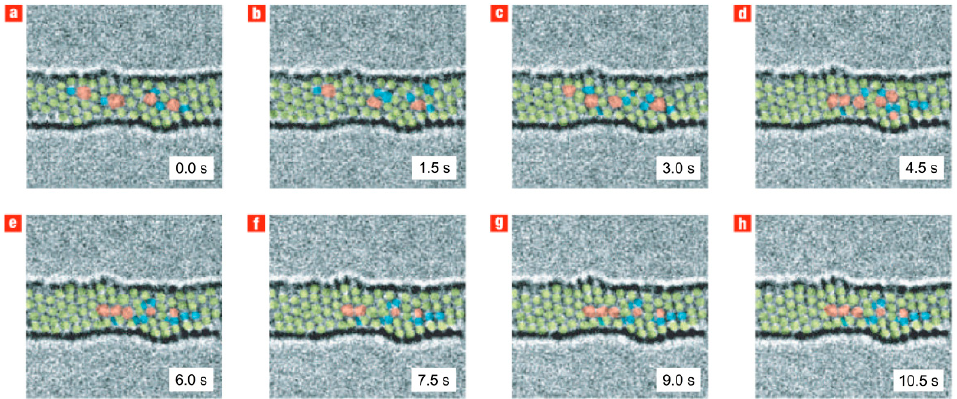
Figure 39. Active topological defects observed by in situ HRTEM. ( a – h ) Sequential HRTEM images of an SWNT layer. Heptagons or higher-membered rings (red), hexagons (green), and pentagons or smaller rings (blue) of carbon atoms tend to gather around the kink structure during observations. Reproduced with permission from Suenaga et al. [116]. Copyright Nature, 2007.